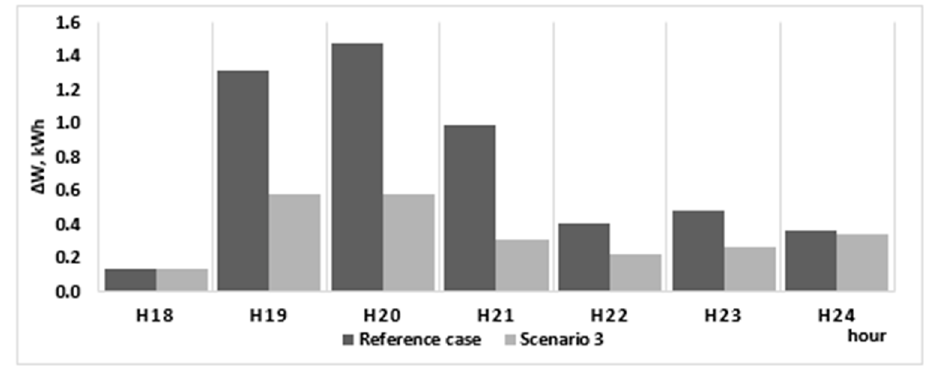
Figure 14. The energy loss pattern at battery discharging hours, Scenario 3.